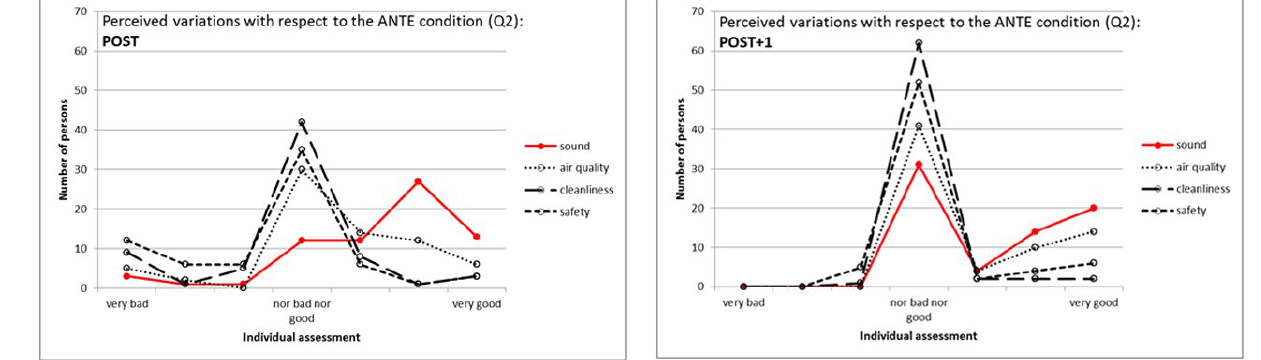
Figure 7: Individual responses’ distributions for Q2 for the four considered environmental aspects ( POST + 1